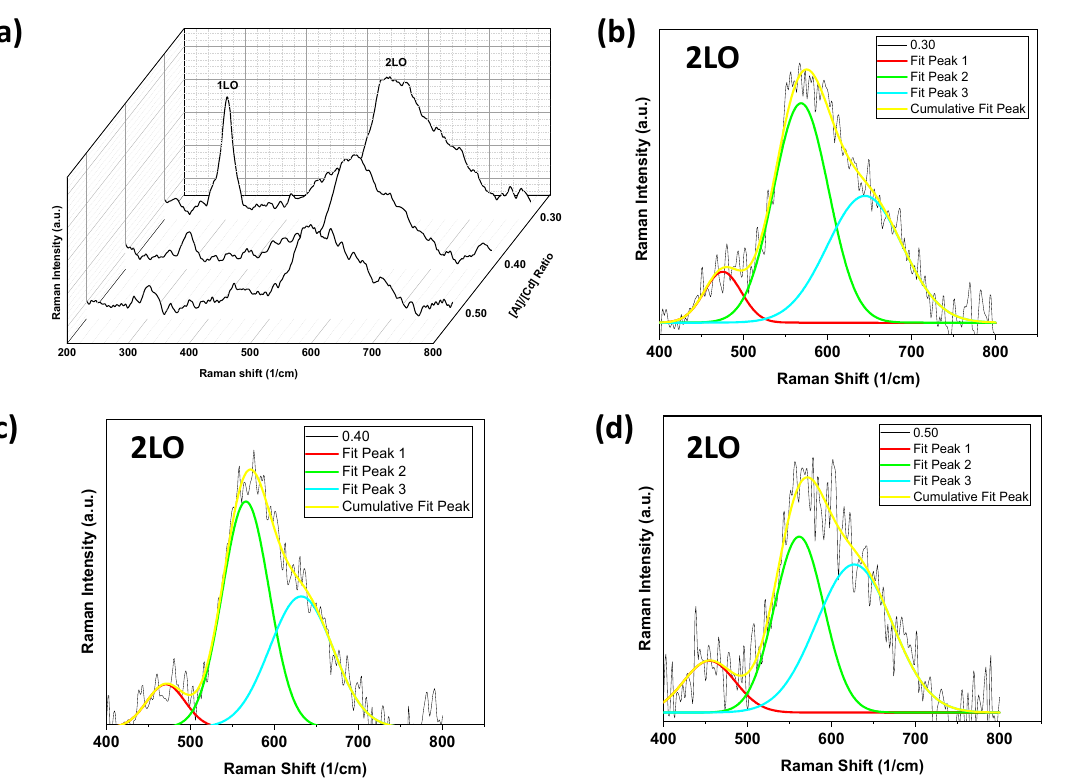
Figure 3. ( a ) Raman spectra of CdS:Al thin films. ( b – d ) Fundamental 2LO overtone fitted using a GaussAmp function. Table 2. Vibration modes found in the Raman spectra of fabricated thin fi lms by the CBD method.